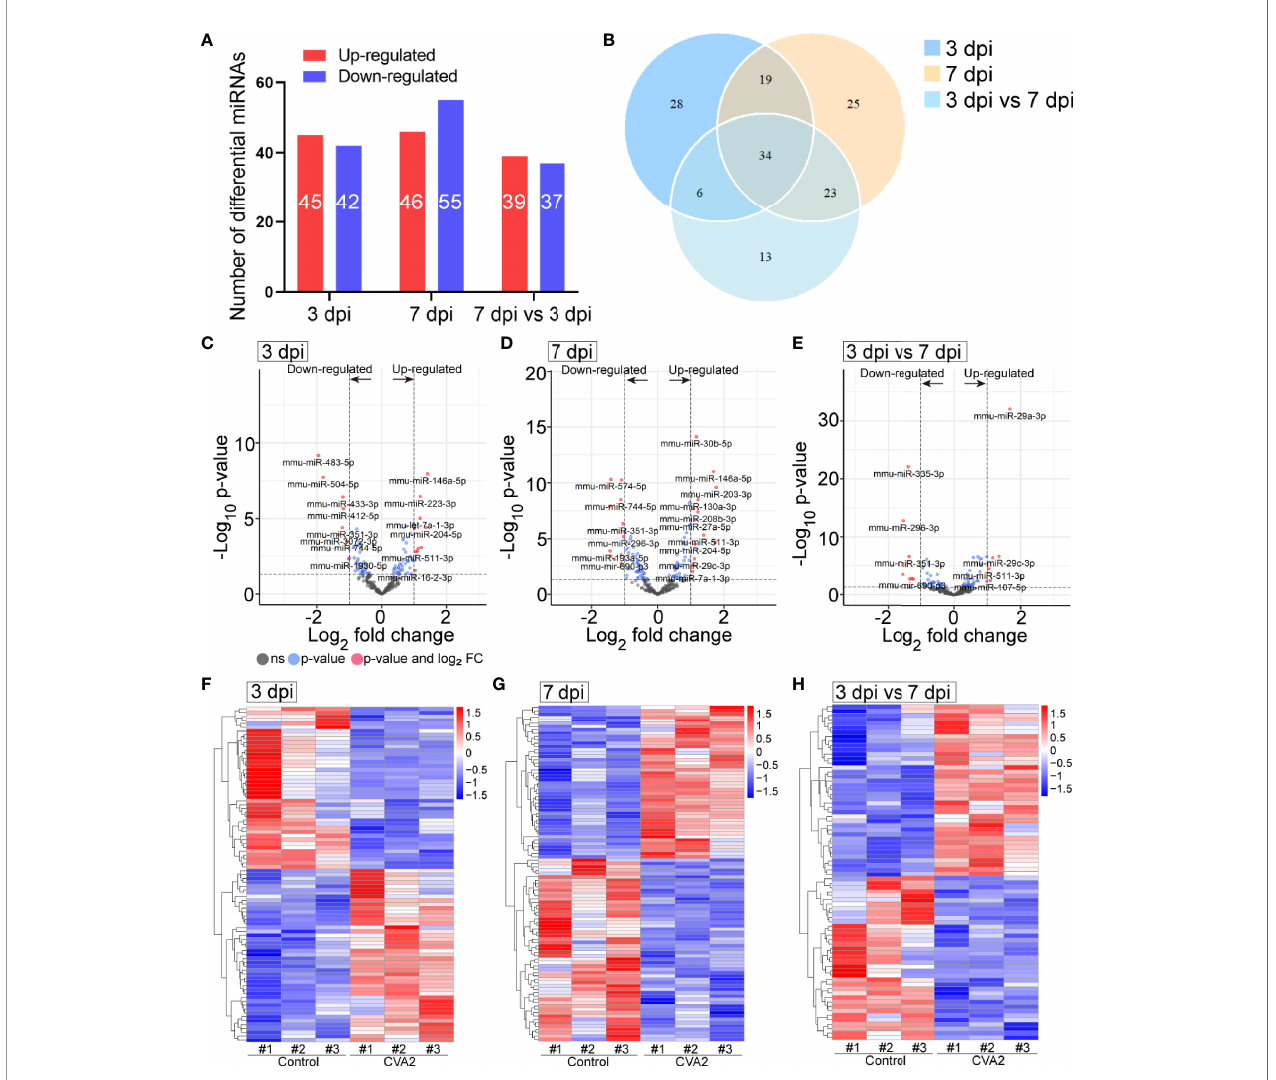
FIGURE 3 | The differentially expressed miRNAs in heart tissues of CVA2-infected mice. (A) Statistics of differentially expressed miRNAs among samples. (B) Venn diagram representation of differentially expressed miRNAs sharing and exclusive constitutively presented among samples. (C – E) Volcano plots of the − log 10 p value vs the log 2 miRNAs abundance comparisons between control and CVA2 infected hearts. MiRNAs outside the signi fi cance threshold lines with p-value < 0.05 were colored in blue, and miRNAs with p value < 0.05 and |log2 (fold change)| > 1.0 were colored in red. (F – H) Heatmaps of differentially expressed